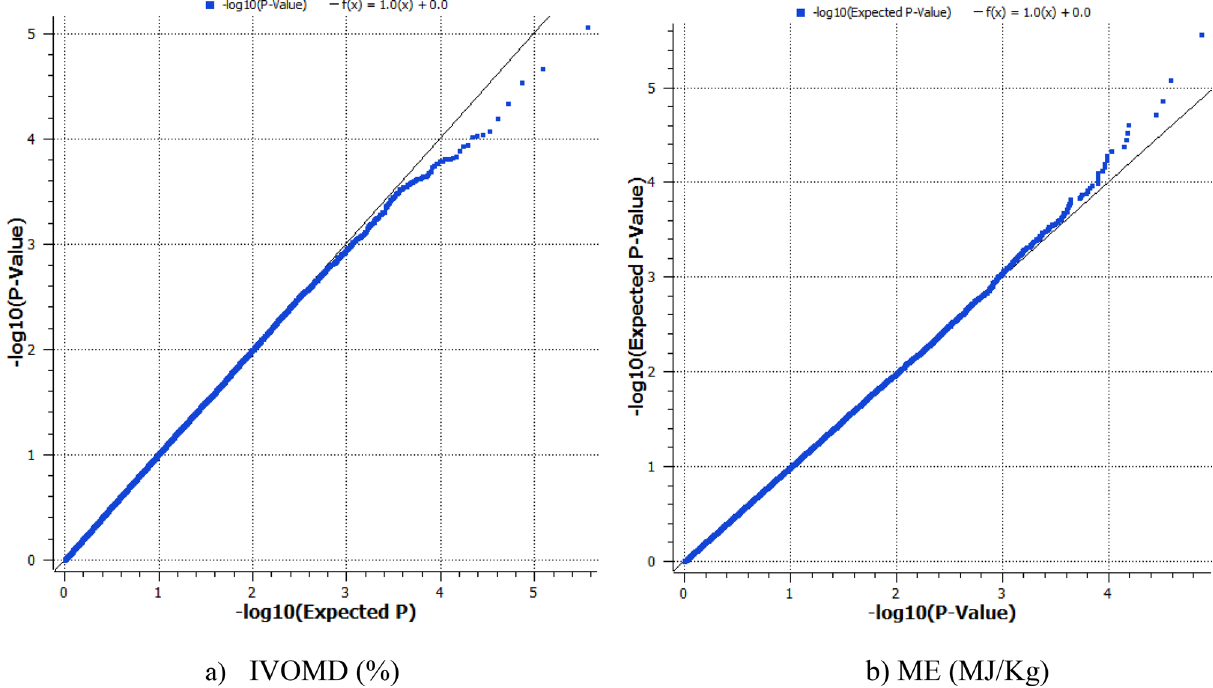
Figure 3. Quantile–quantile plots representing the SNP associations through MLM for the two stover quality traits ( a ) IVOMD and ( b )